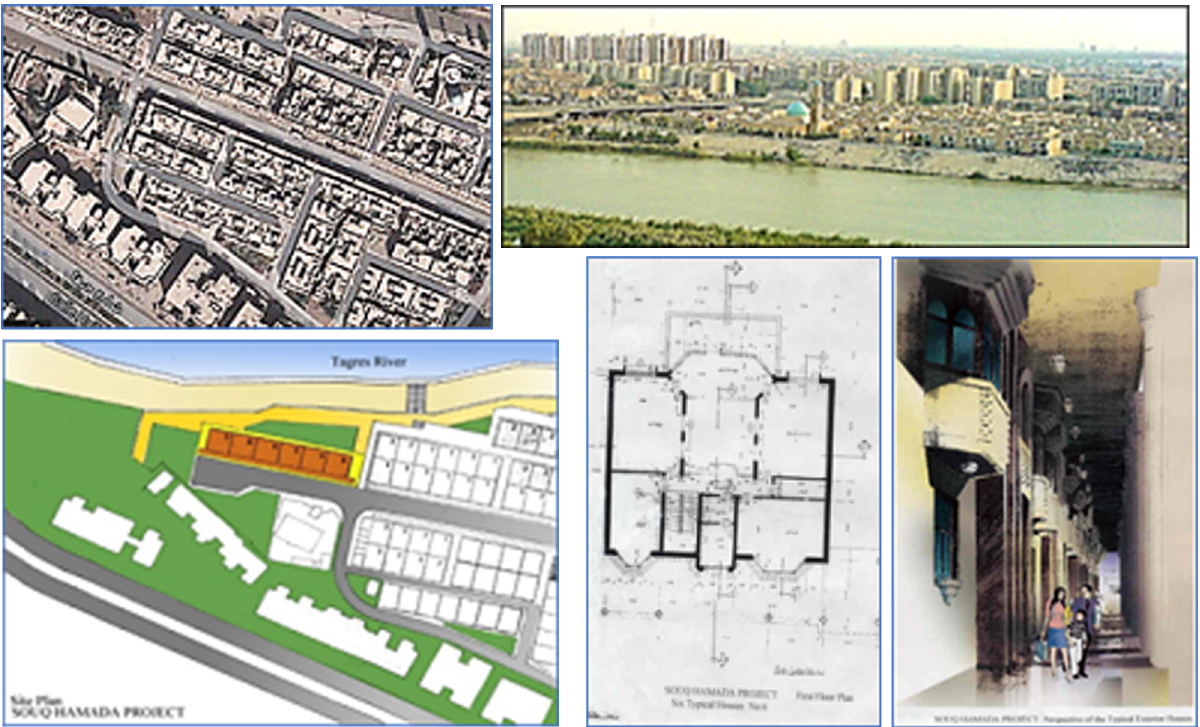
Fig. 9. (Above) Examples of six row houses close to Tigris River in Baghdad, which use the courtyard design in two fl oors covered by a dome, and windows from all sides to provide cross ventilation and wind breeze by using traditional materials only. Designed by the Author in Baghdad,1992. (Down left-hand layout) (cid:1) Souq Hamada Neighborhood design by IDRISI Center for Engineering Consultant- Baghdad-Iraq 1992.